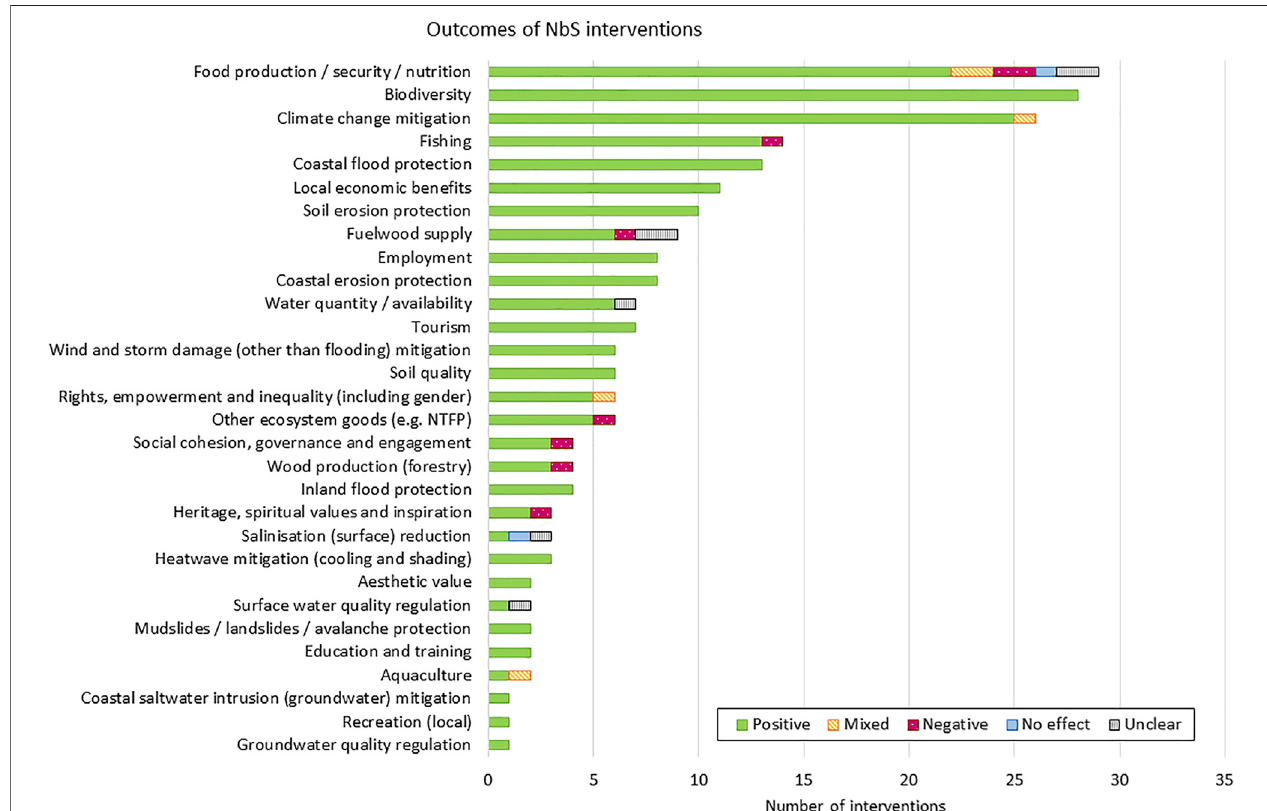
FIGURE 3 | Number of interventions with positive, negative or mixed outcomes for addressing climate and natural hazards and other sustainable development goals.